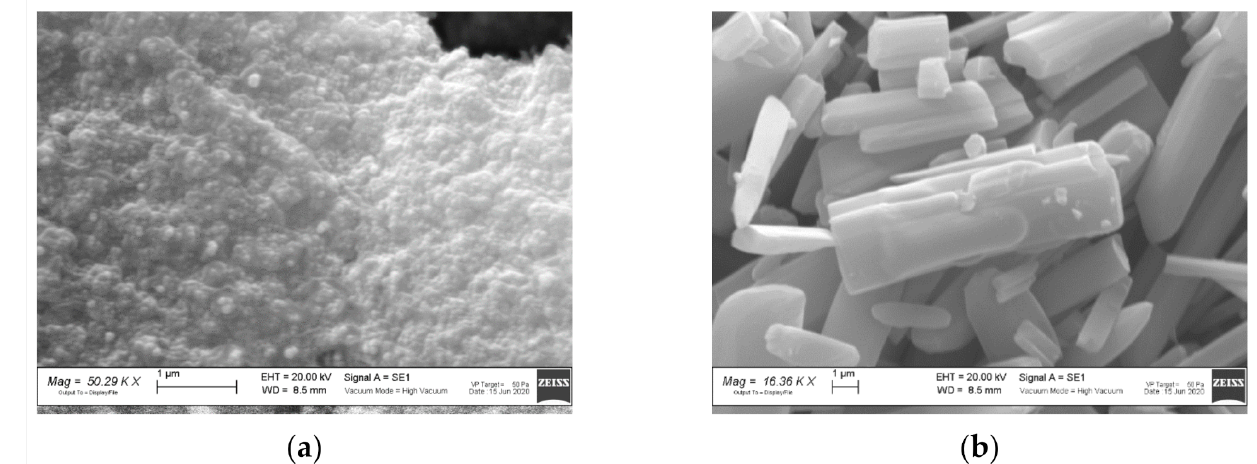
Figure 3. Scanning Electron Microscopy (SEM) images of ( a ) ZIF-8 and ( b ) Zn 3 (BTC) 2